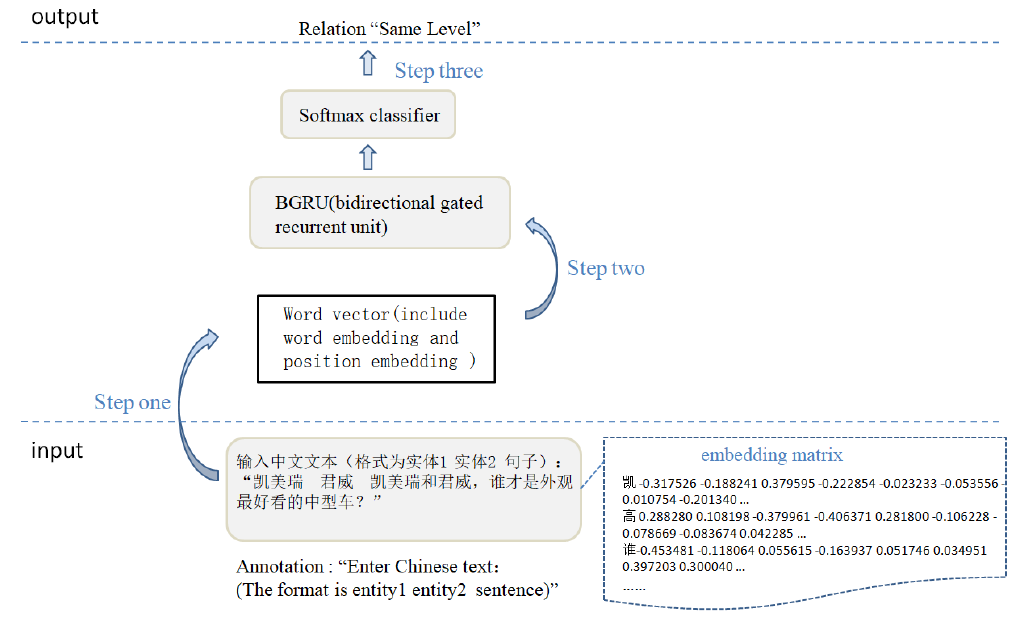
Figure 2. The pipeline of semantic relation